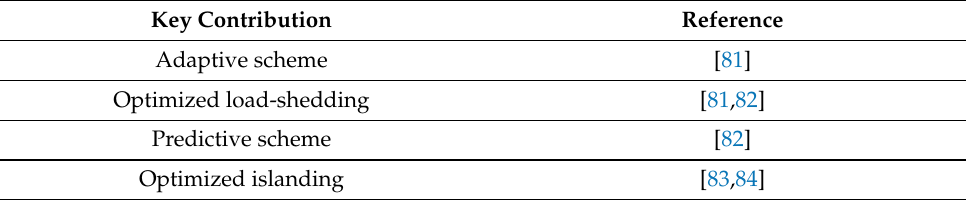
Table 5. Summary of